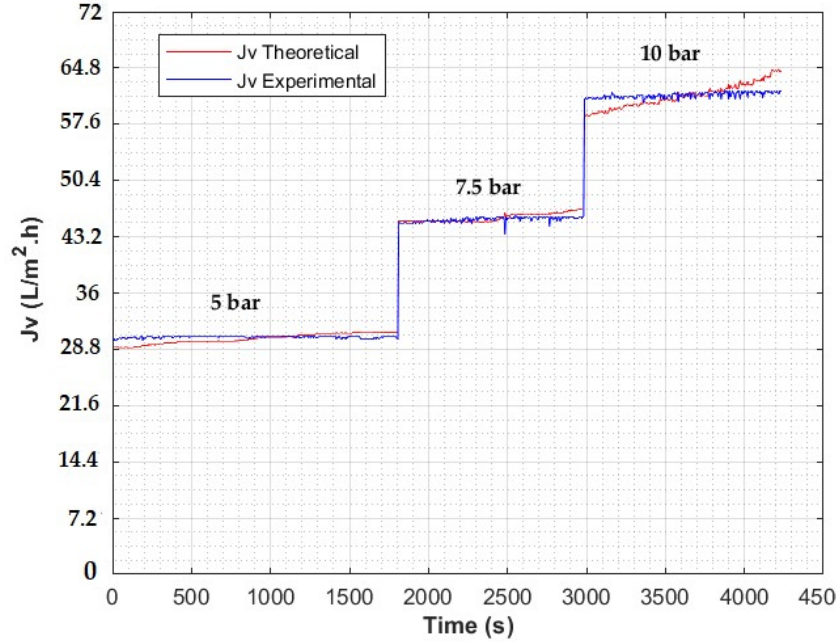
Figure 13. Theoretical vs. experimental flux of Pb: high concentration.